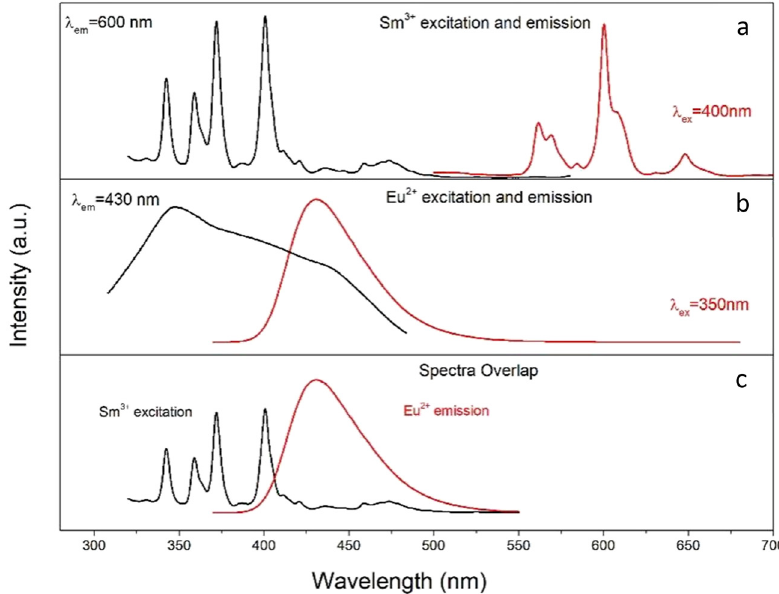
Figure 7: PL and PLE spectra of ( a ) KBP:0.12Sm 3 + , ( b ) KBP:0.1% Eu 2 + , and ( c ) the PL of Eu 2 + and PLE of Sm 3 + in